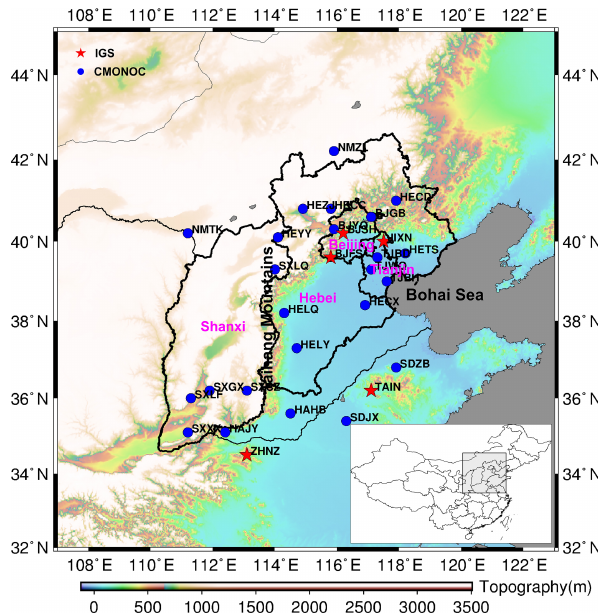
Figure 1. Study region of the North Plain China (NCP) show- ing locations of continuous GPS stations. Blue dots represent con- tinuous GPS sites in the Crustal Movement Observation Network of China (CMONOC) and red stars represent the International GNSS Service (IGS) sites). Cities and provinces are labelled as fol- lows: Beijing (BJ), Tianjin (TJ), Hebei province (HE), and Shanxi province